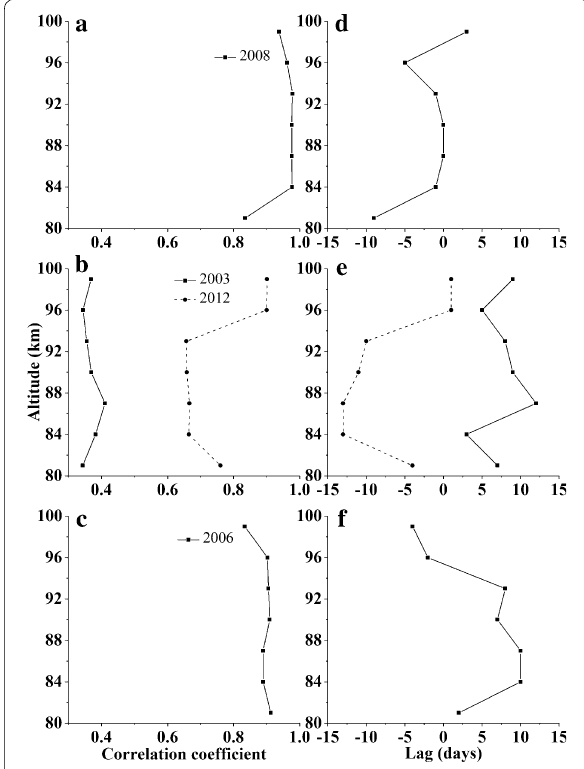
Fig. 7 Same as shown in Fig. 6, but here it is for the zonal terdiurnal